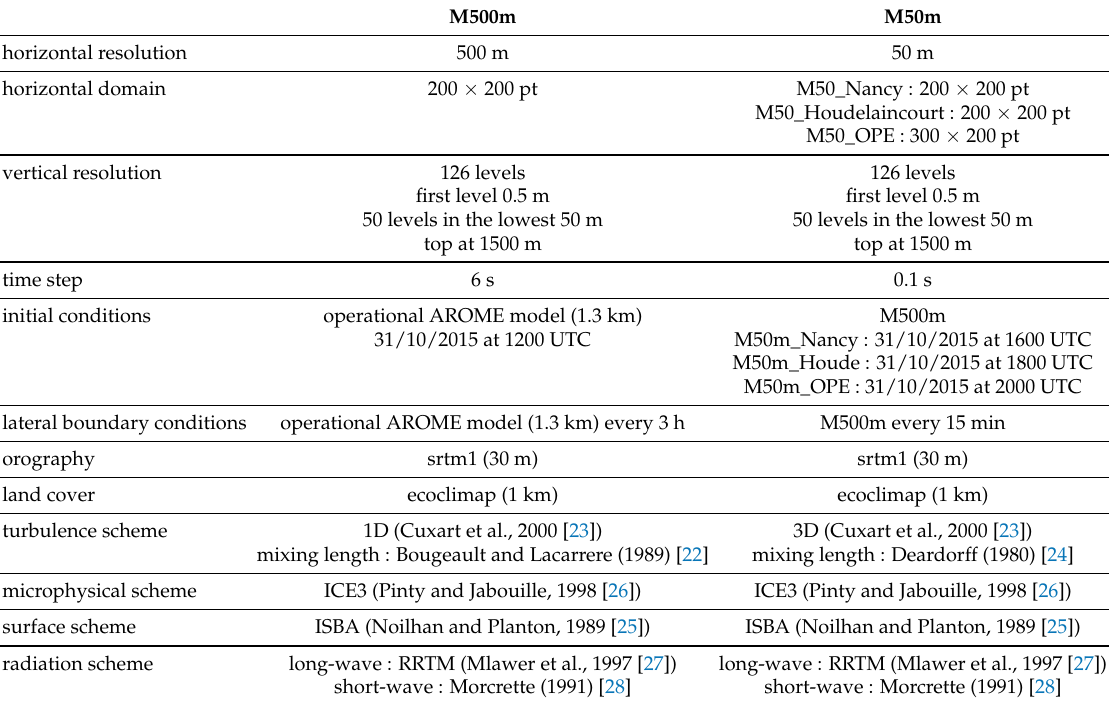
Table 1. Summary of model